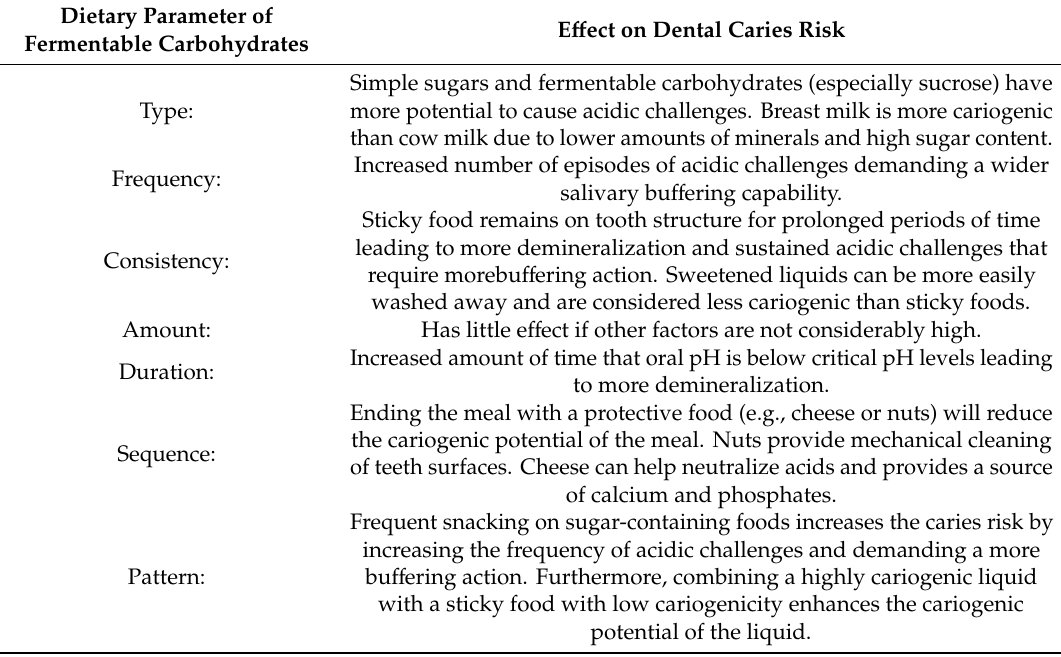
Table 2. Dietary parameters that can a ff ect the caries risk